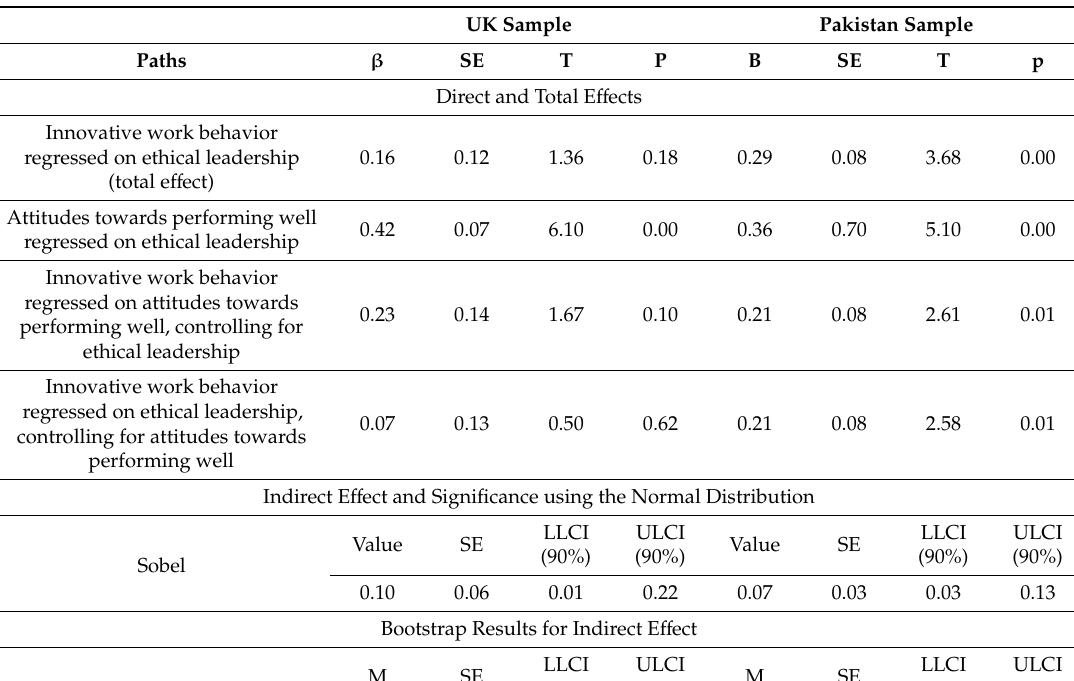
Table 5. Regression Results for Simple Mediation: Attitudes Towards Performing Well. UK Sample Pakistan